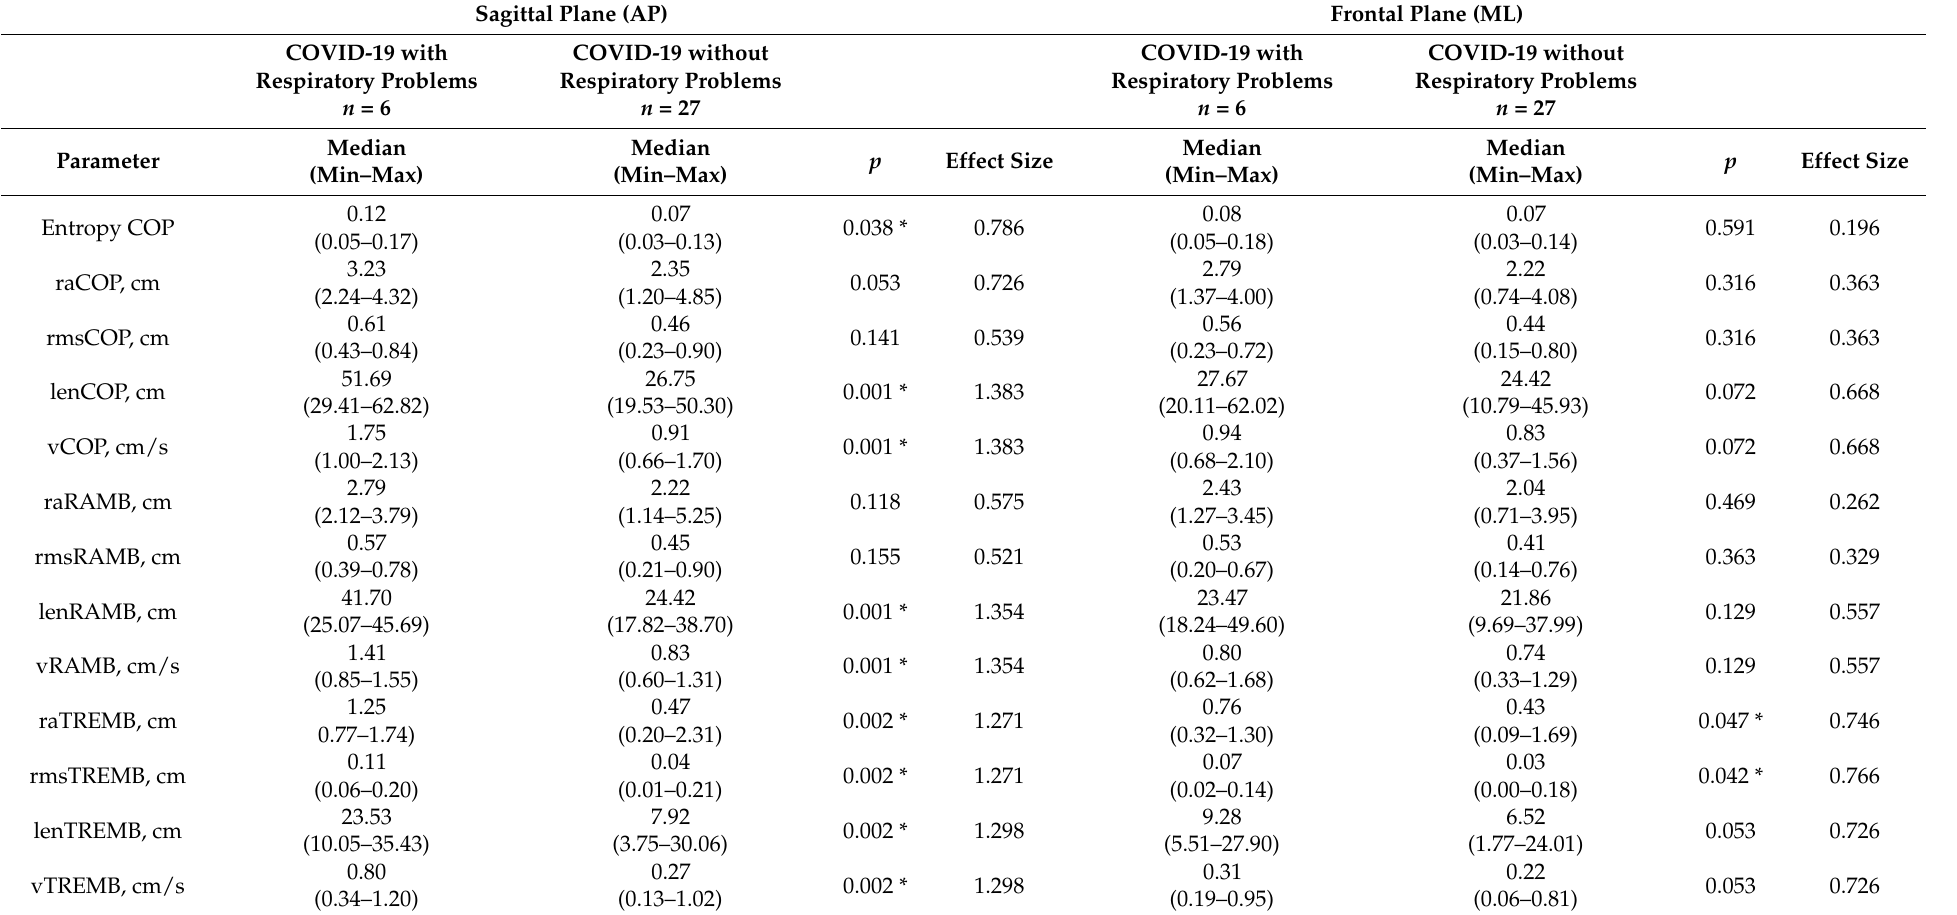
Table 3. Comparison of the stabilographic parameters (closed eyes) in subjects who reported respiratory problems ( n = 6) in the course of COVID-19 and those who did not suffer from dyspnea during the infection ( n = 27) (AP, anterio-posterior direction; ML, medio-lateral direction; COP, center of pressure; ra, range; rms, root mean square; len, length of trajectory; v, velocity; RAMB, rambling; TREMB, trembling) (* statistically